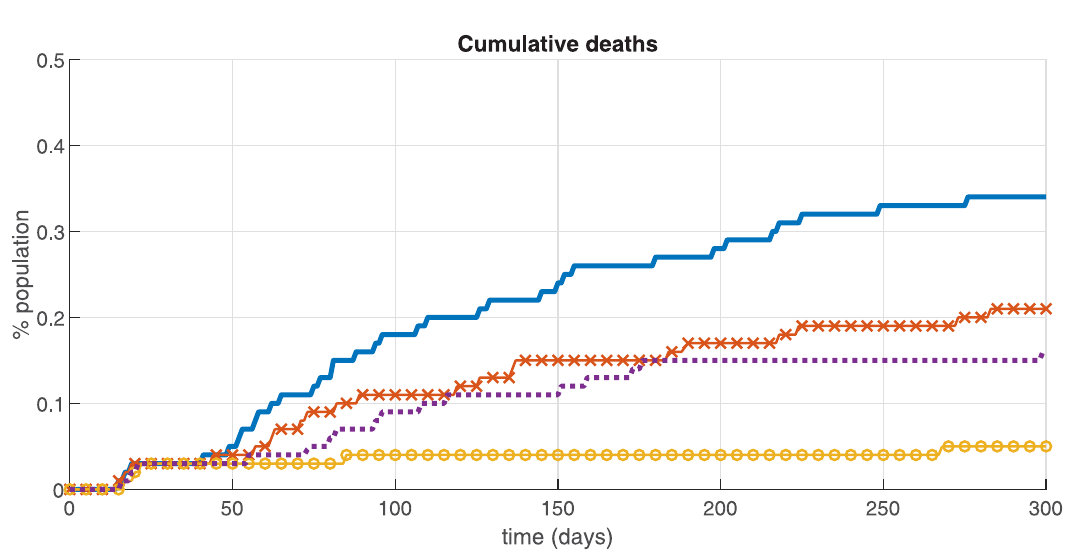
Fig 1. Regular graphs example—Local vs. bridge